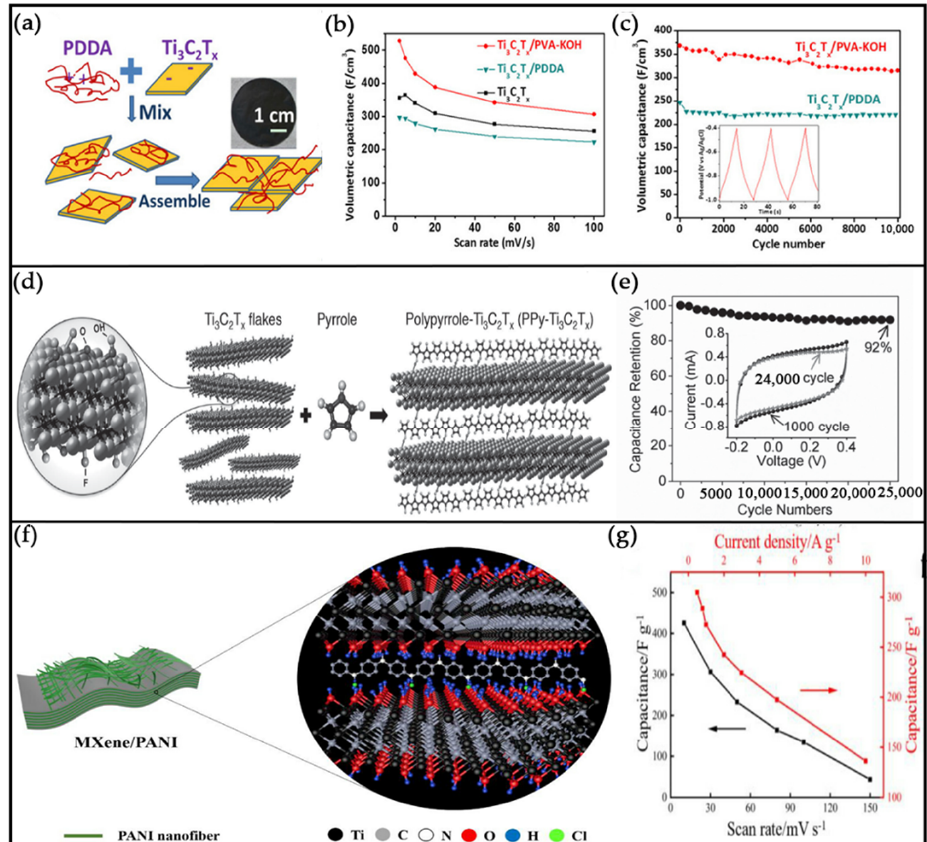
Figure 10. ( a ) Schematic illustration of the preparation of Ti 3 C 2 T x /PDDA films. ( b ) Volumetric capacitances at different scan rates for Ti 3 C 2 T x , Ti 3 C 2 T x /PDDA, and Ti 3 C 2 T x /PVA − KOH films. ( c ) Cyclic stability of Ti 3 C 2 T x /PDDA and Ti 3 C 2 T x /PVA − KOH electrodes at a current density of 5 A g − 1 ; the inset shows the last three cycles of a Ti 3 C 2 T x /PVA − KOH capacitor. Reprinted with permission from Ref. [148]. Copyright 2014 PNAS . ( d ) Schematic illustration of pyrrole polymerization using MXene. The terminating groups on the latter contribute to the polymerization process. ( e ) Cycle life performance showing high capacitance retention of the PPy/Ti 3 C 2 T x (1:2) film after 25,000 cycles at 100 mV s − 1 . Inset shows that the shape of the CV was retained after cycling, confirming the high electrochemical stability. Reprinted with permission from Ref. [149]. Copyright 2015 WILEY-VCH Verlag GmbH & Co., KGaA. ( f ) Schematic diagram of binding mechanism between MXene nanosheets and PANI nanofibers of the PPy confined between the MXene layers. ( g ) The plot of specific capacitance versus scan rates and current densities for MP5. Reprinted with permission from Ref. [150]. Copyright 2022 Electrochimica Acta